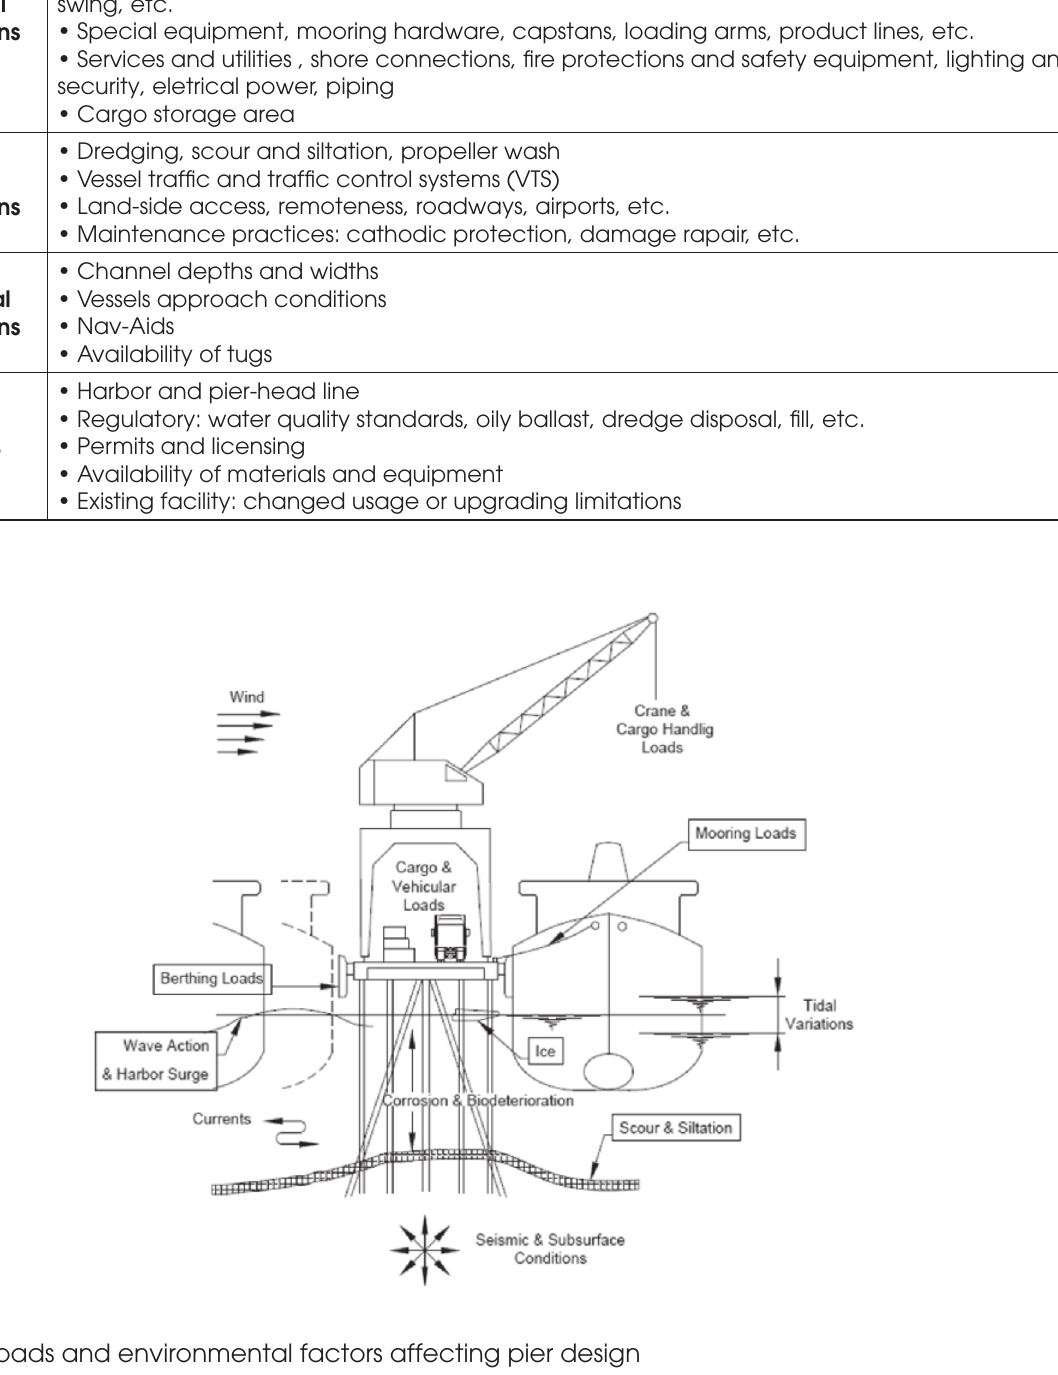
Generalized loads and environmental factors affecting pier